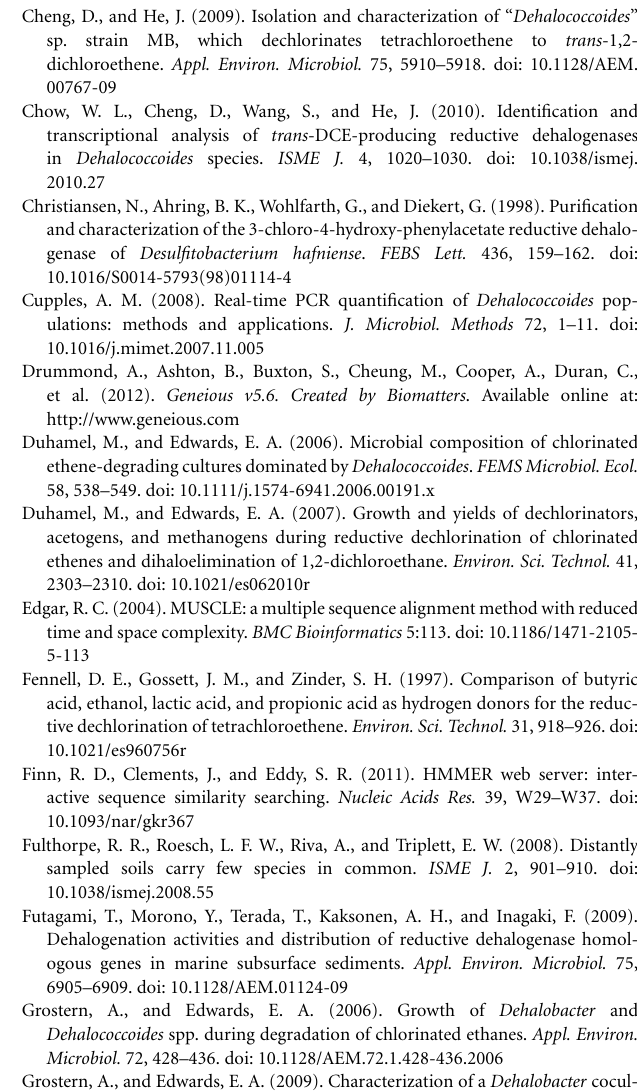
Data sheet 1: Table S1 | Reductive dehalogenase primer suite summary information. Expected product size, primer sequences, melting temperature ranges, and degeneracy levels are listed. Data sheet 2: Table S2 | rdhA gene information, including NCBI accessions, best blast matches to the curated RdhA dataset and to NCBI’s protein non-redundant database, gene length, and predicted primer group and reductive dehalogenase ortholog groups (RD_OG) for each novel rdhA . Data sheet 3: Table S3 | Reductive dehalogenase homologous genes curated reference dataset information, with tree identifiers linked to NCBI, JGI, or in-house accession numbers and organism of origin. Data sheet 4: Table S4 | Companion table to Figure 6, with accession numbers for all sequences included in the abundance table groups, and associated primer groups and RD_OGs for each row. Datasheet 5: Figure S1 | Maximum likelihood trees of the reductive dehalogenase primer groups for which newly sequenced RdhA were identified, including the new RdhAs and the reductive dehalogenase curated dataset sequences. Sequences for each primer group or set of alignments manually curated. Trees were generated in PhyML